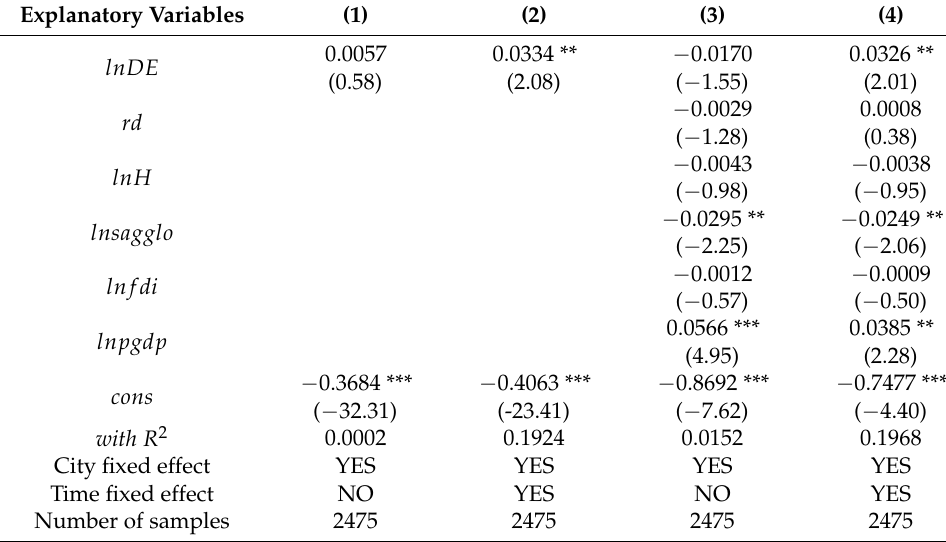
Table 4. Full sample estimation